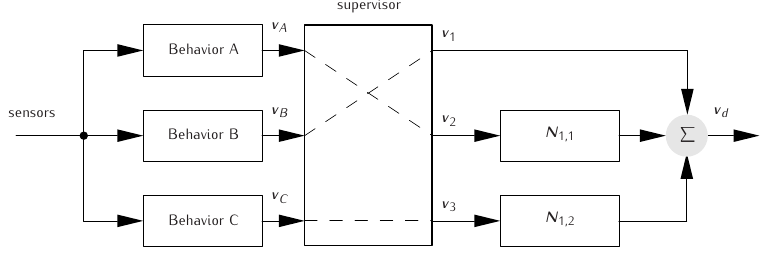
Figure 1. Sketch of the Null-Space-based Behavioral control in a 3-behavior example given by equation 5. The supervisor is in charge of changing the relative priority among the behaviors.